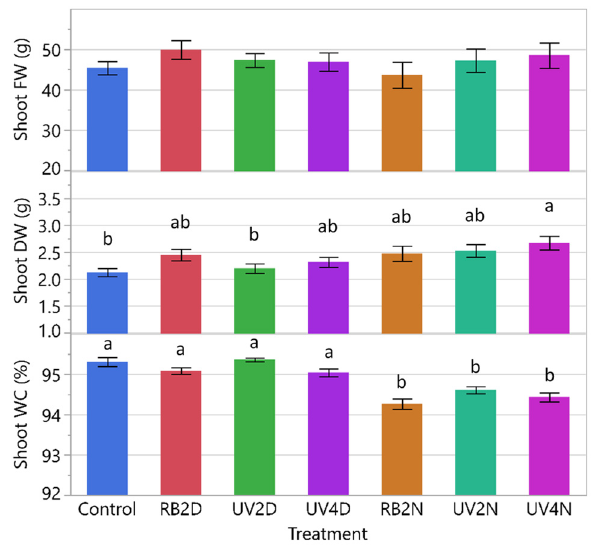
Figure 5. Shoot fresh weight (FW), dry weight (DW), and shoot water content (WC) of the lettuce variety ‘Red Mist’ treated with pre-harvest supplemental UV-A/Blue (UV) or Red and Blue (RB) LED light for a duration of either two or four days (D) or nights (N), in a greenhouse hydroponic system (Experiment 2). The control plants did not receive any supplemental LED light. See Table 2 for treatment details. Means separated by different letters indicate significant differences according to Tukey’s HSD ( honestly significant difference ) test ( p < 0.05). Bars represent standard error.